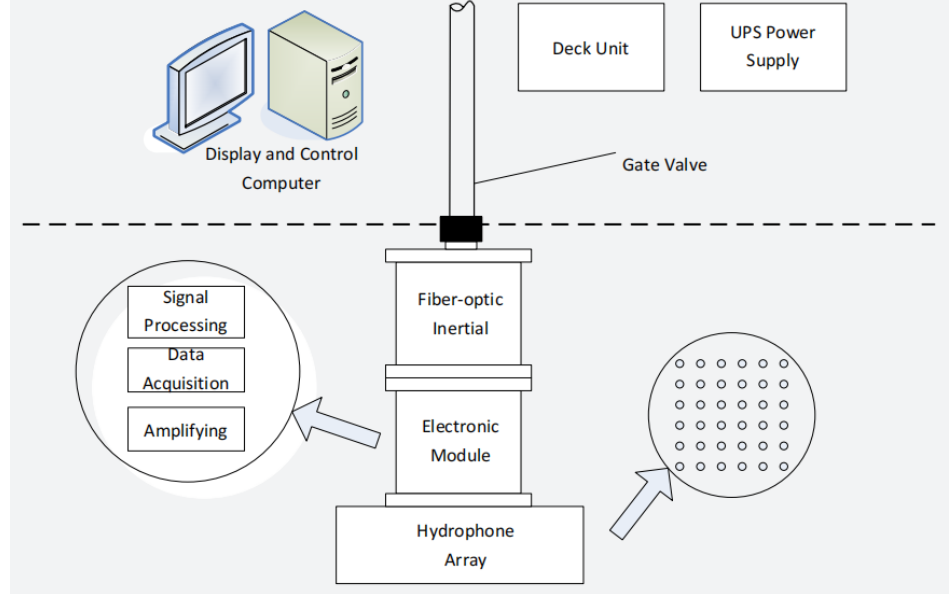
Figure 13. Ultra-short base line positioning system [19].